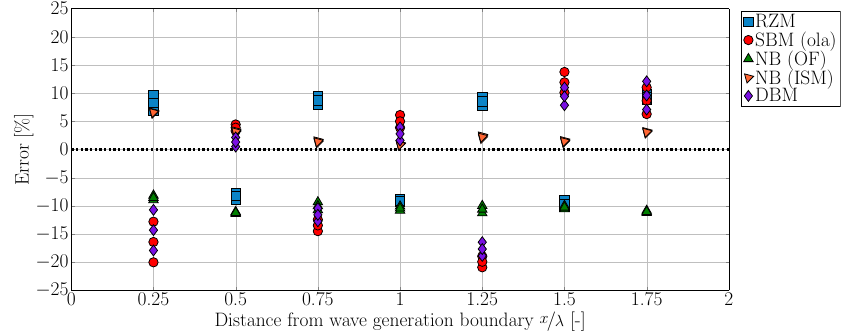
σ ¯ (cid:101) for the deep water mSS at different locations along the Figure 21. ¯ (cid:101) ¯ H ± ¯ H